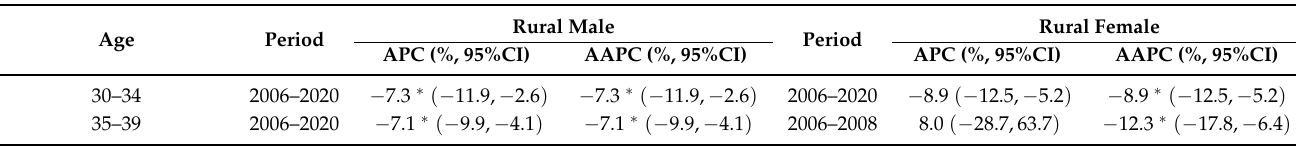
Table 4. Temporal trend analysis of age–specific mortality rates for RHD in rural Chinese